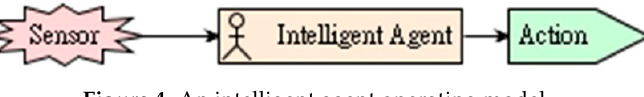
Figure 4. An intelligent agent operating model.